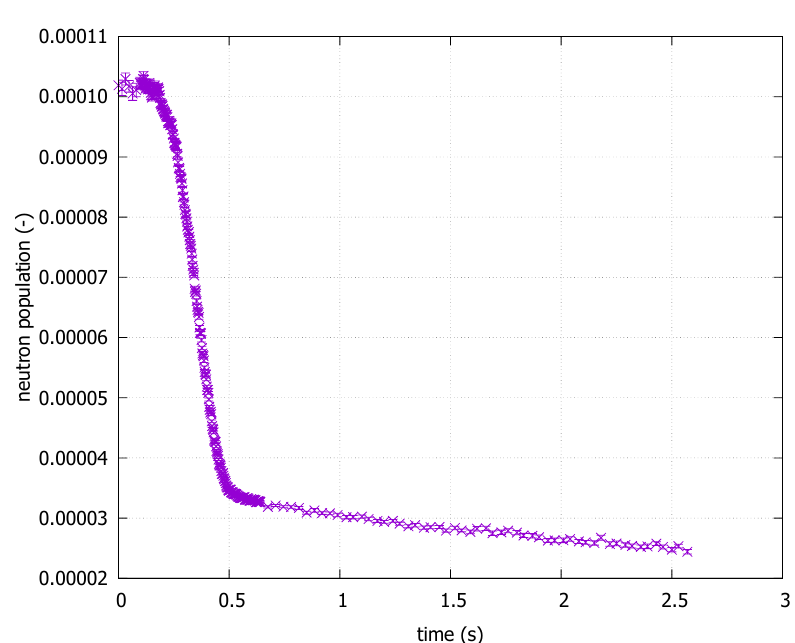
Figure 3: The neutron flux development during and after rod drop calculated by Serpent